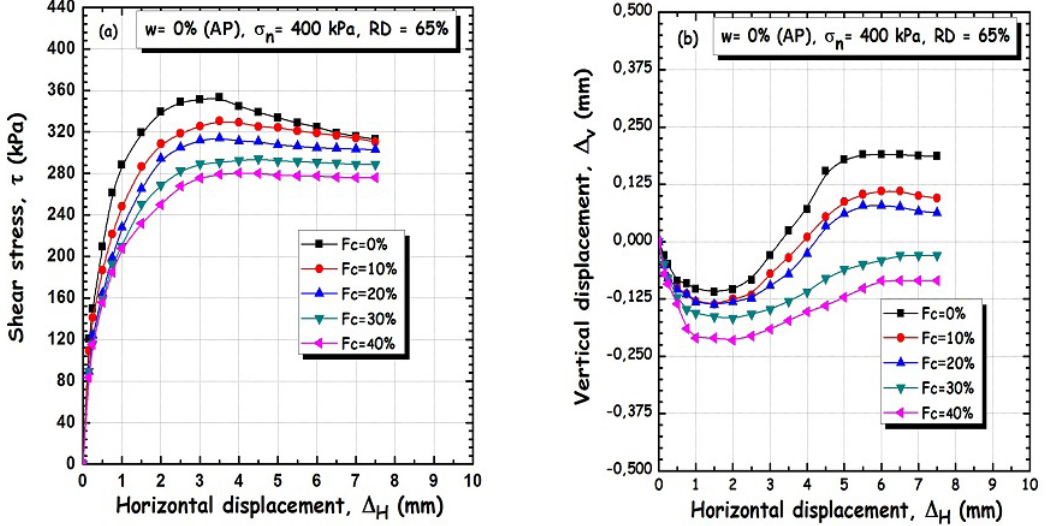
= 400 kPa): (a) variation of the shear n